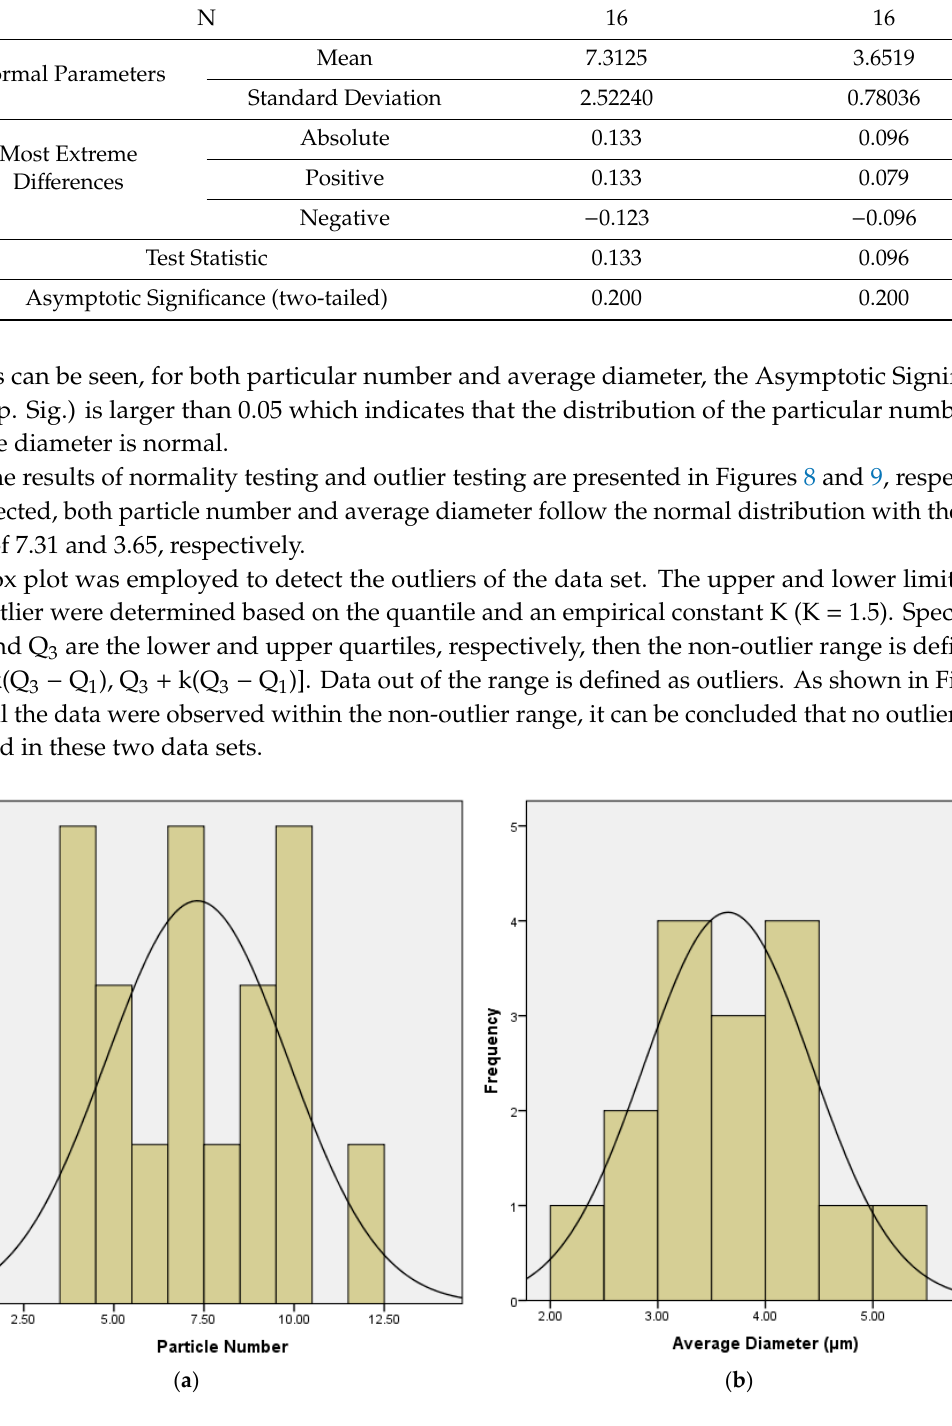
Figure 8. Results of normality test: ( a ) particle number and ( b ) average diameter.